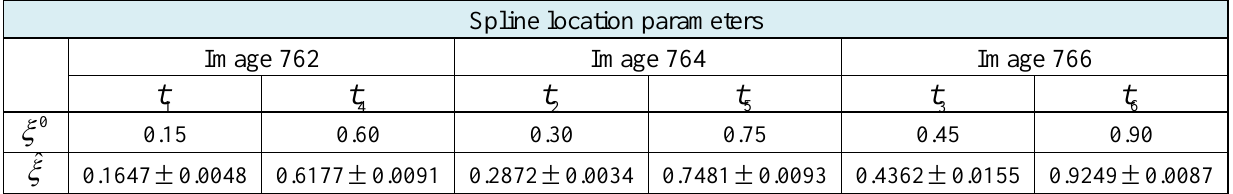
Table 10. Spline location parameter